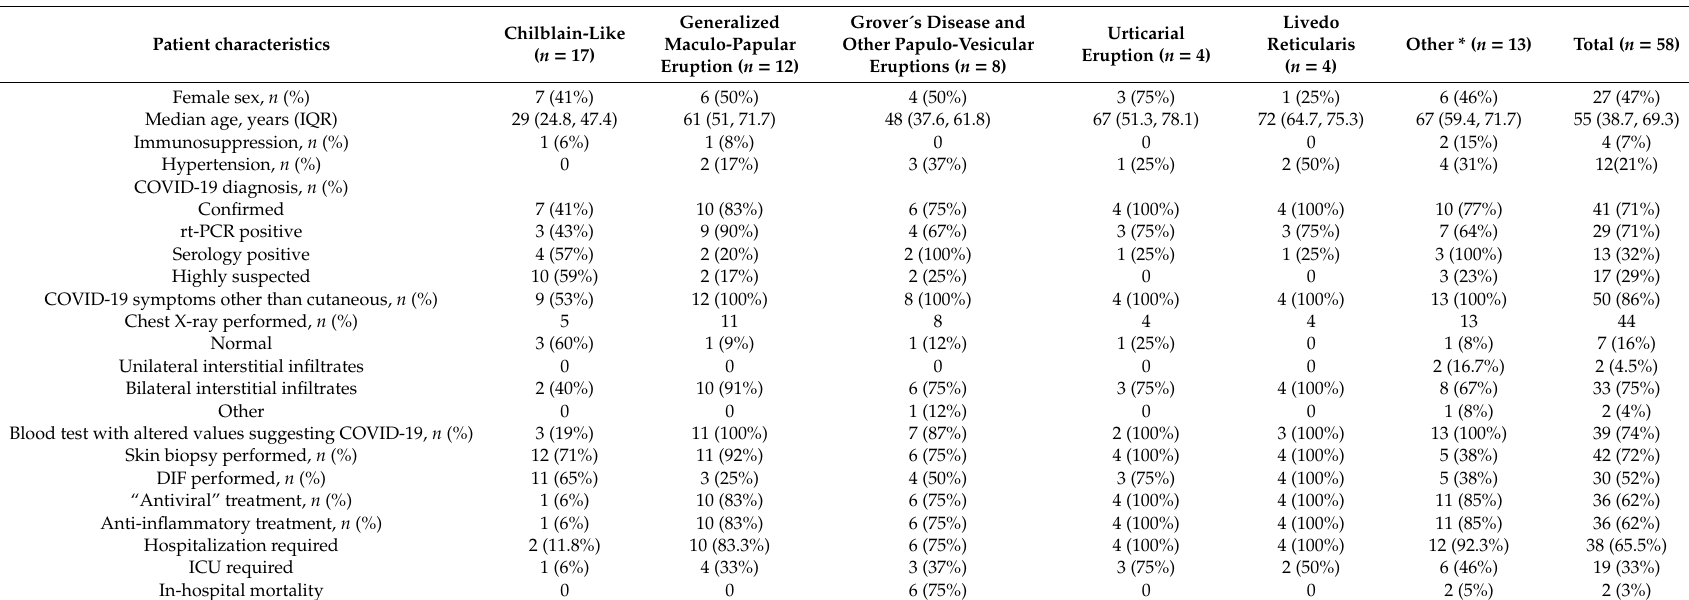
Table 1. Basal characteristics of the 58 patients included in the study according to the dermatological skin patterns. Patient